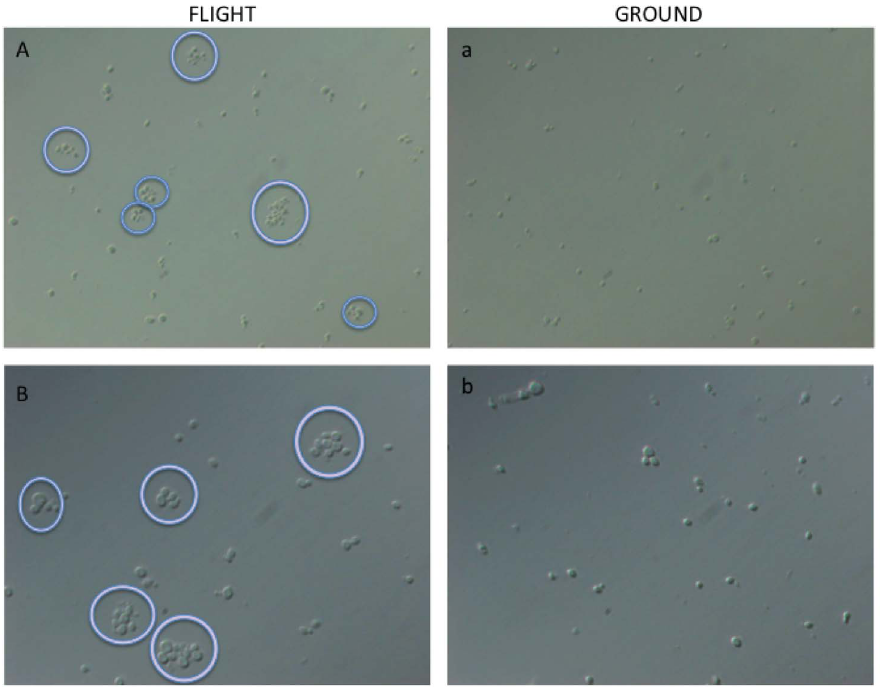
Figure 3. Light microscopic analyses of fixed cultured in spaceflight (A, B) and ground control (a, b) conditions. Panels A and B: Differential interface contrast (DIC) images at 400 6 magnification. Panels a, b: DIC images are 630 6 magnification. Purple circles indicate c ell clumps